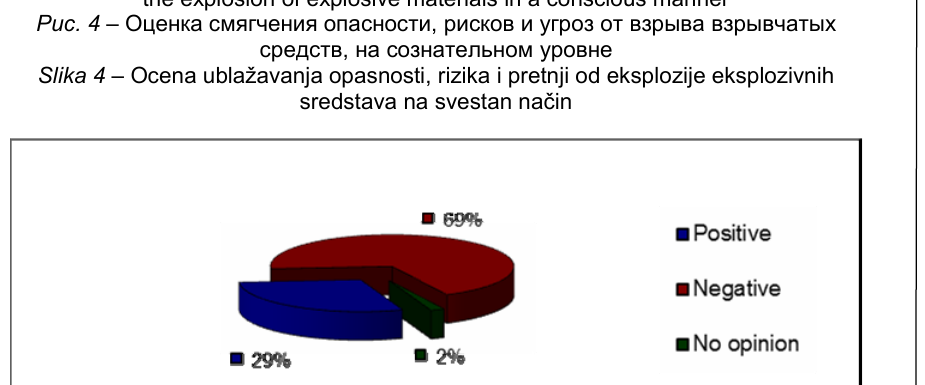
Figure 4 – Assessment of the mitigation of hazards, risks and threats from the effects of the explosion of explosive materials in a conscious manner